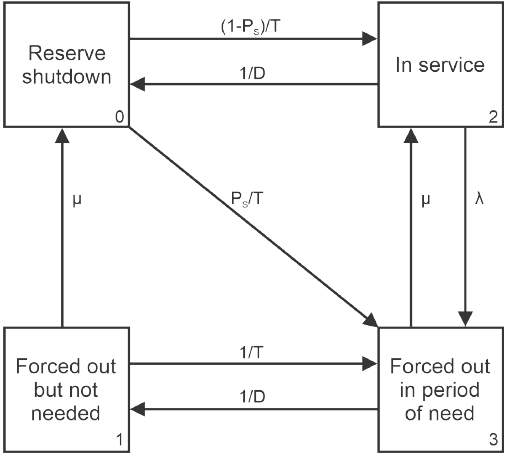
Figure 3. Four-state generator model (Reproduced from [1], Plenum Press,